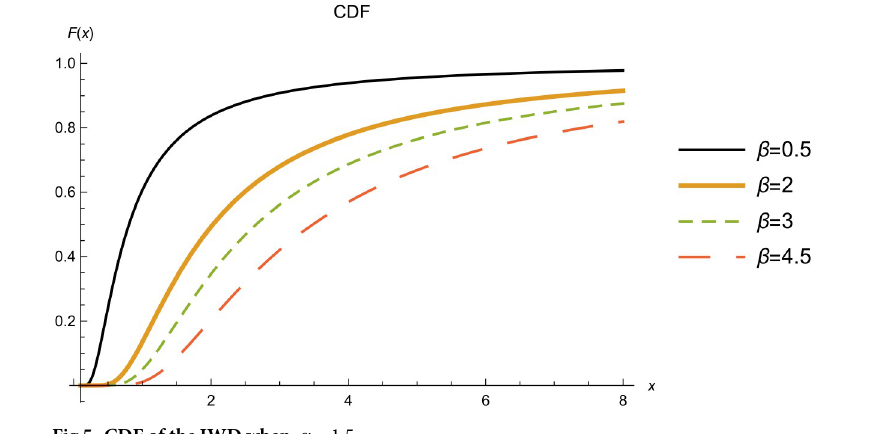
Fig 5. CDF of the IWD when. α =